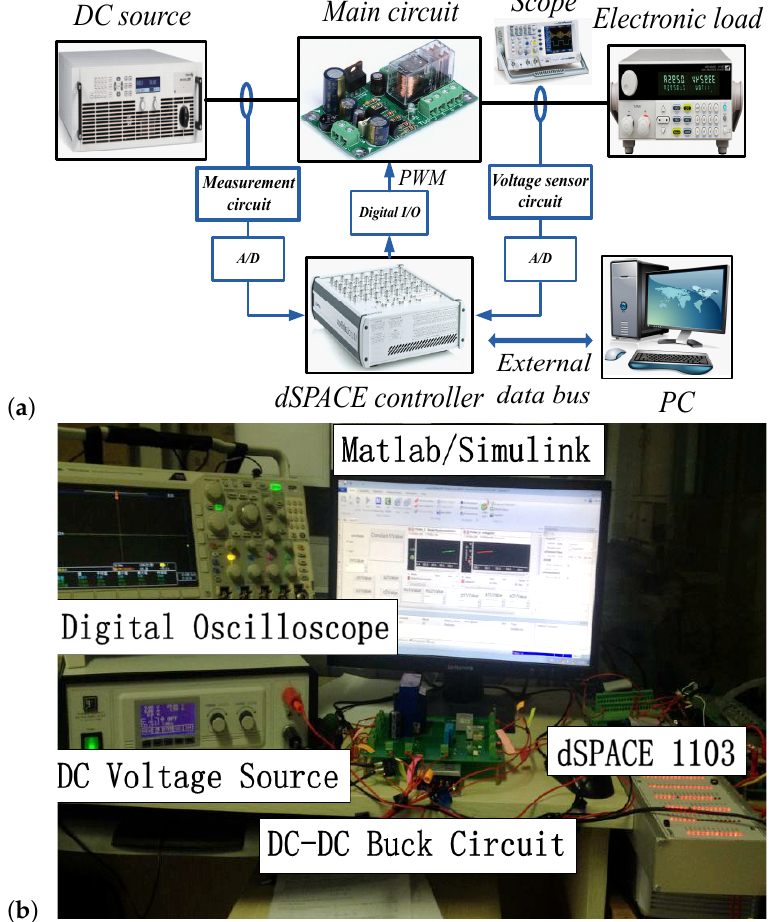
Figure 2. Experimental test setup. ( a ) Configuration. ( b ) Photograph of